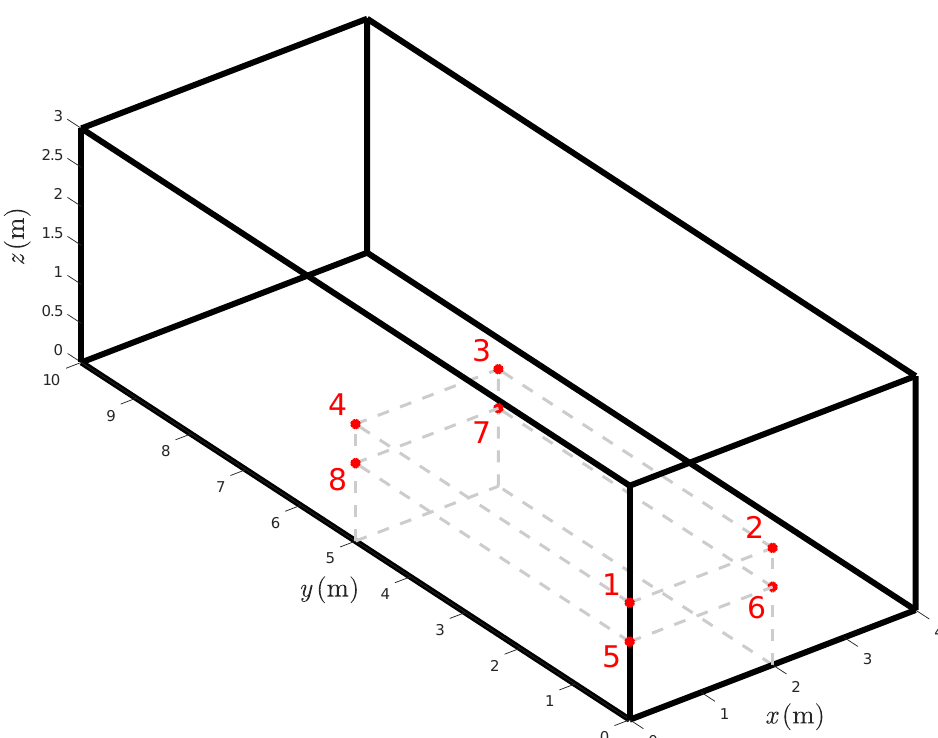
Figure 1. The eight positions of the Target Node (TN) used for experiments are numbered and shown in red in the considered indoor environment, which is a 4 m wide, 10 m long, and 3 m tall empty corridor.